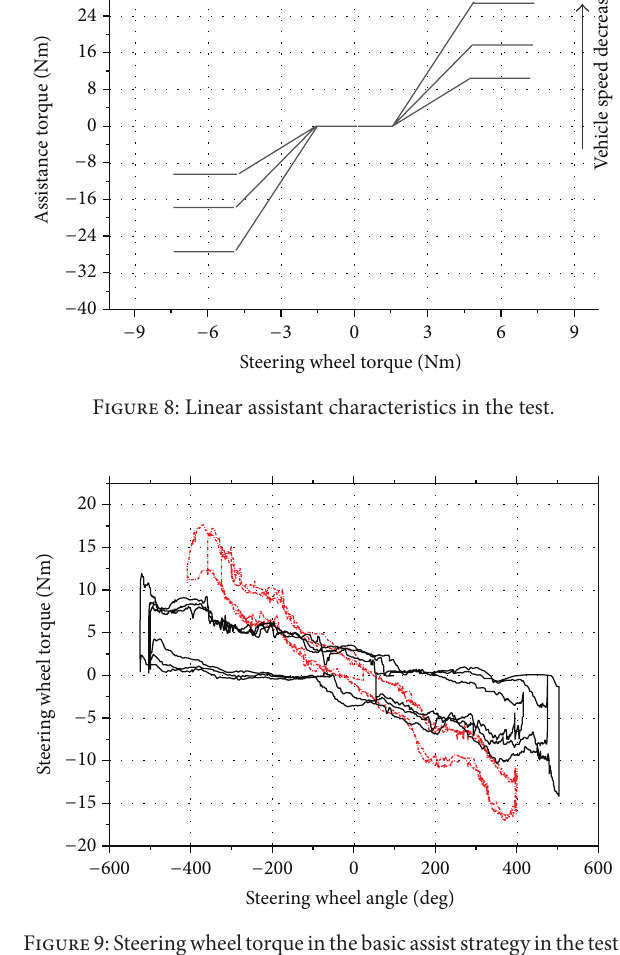
Figure9:Steeringwheeltorqueinthebasicassiststrategyinthetest.